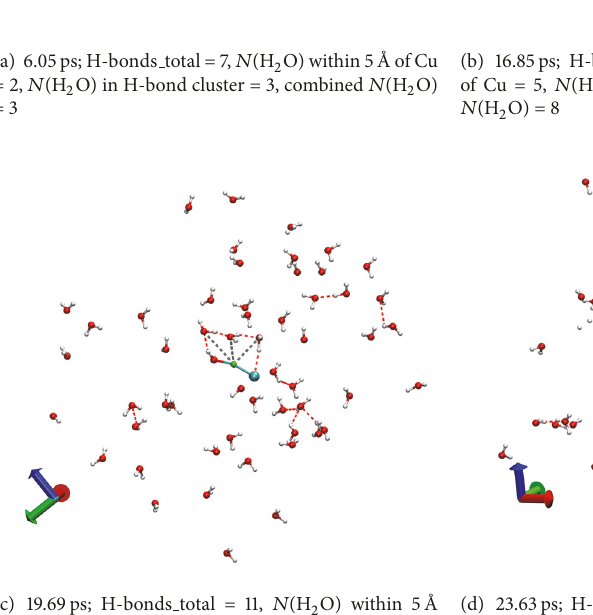
Figure 7: Hydrogen bonds (red dashed lines) and the sphere of O within 5 ˚A of Cu (shown by the grey dashed lines) in the simulation for a density of 0.08 g/cm 3 . 𝑁 (H 2 O) within 5 ˚A of Cu is the hydration number calculated from the RDF and its integral; H-bonds were picked up when the D-H distance was less than 3.5 ˚A and the D-H-A angle less than 70 ∘ ; H-bonds total is the total number of H-bonds in the solution; 0 cluster linked by H-bonds; the combined 𝑁 (H 𝑁 (H 2 O) in an H-bond cluster is the number of water molecules in the [CuCl(H 2 O) 𝑛 ] 2 O) value counts all the water molecules within 5 ˚A of Cu and water molecules beyond 5 ˚A that are linked by H-bonds.